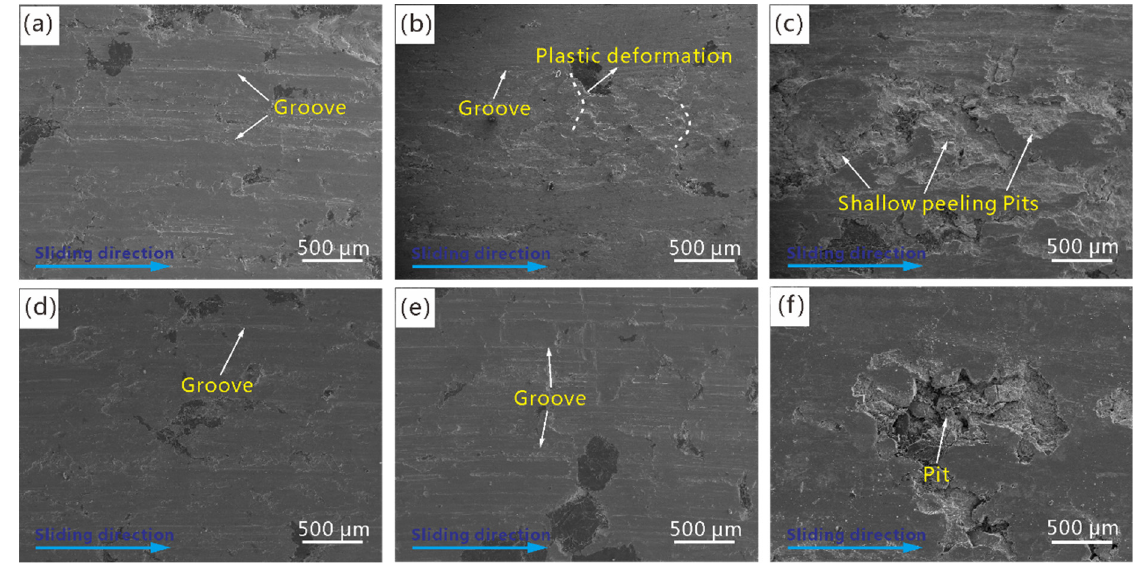
Figure 12. The worn surfaces of Cu–BCs containing Fe and Cr tested under different BEPUAs: ( a ) Fe low-BEPUA; ( b ) Fe medium-BEPUA; ( c ) Fe high-BEPUA; ( d ) Cr low-BEPUA; ( e ) Cr medium-BEPUA; and ( f ) Cr high-BEPUA.